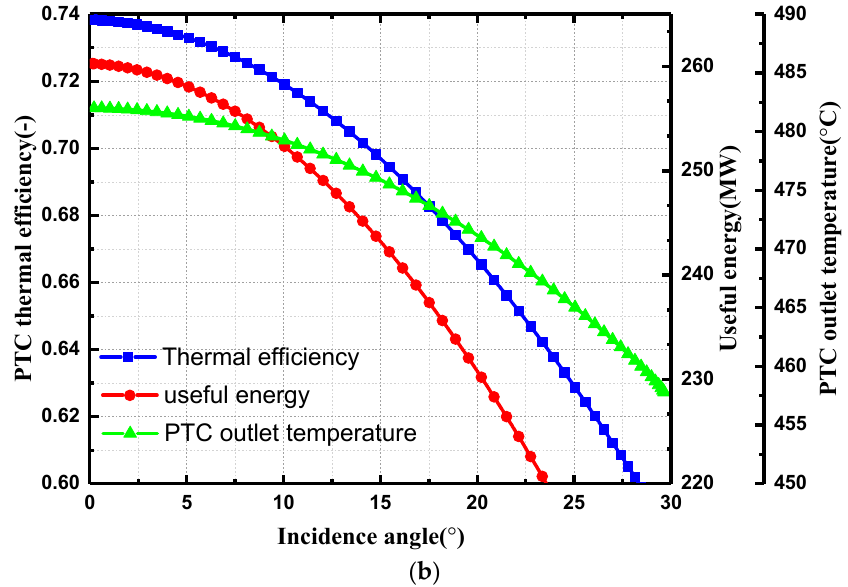
Figure 8. Optical ( a ) and thermal performance ( b ) of the PTC field versus solar incidence angle.